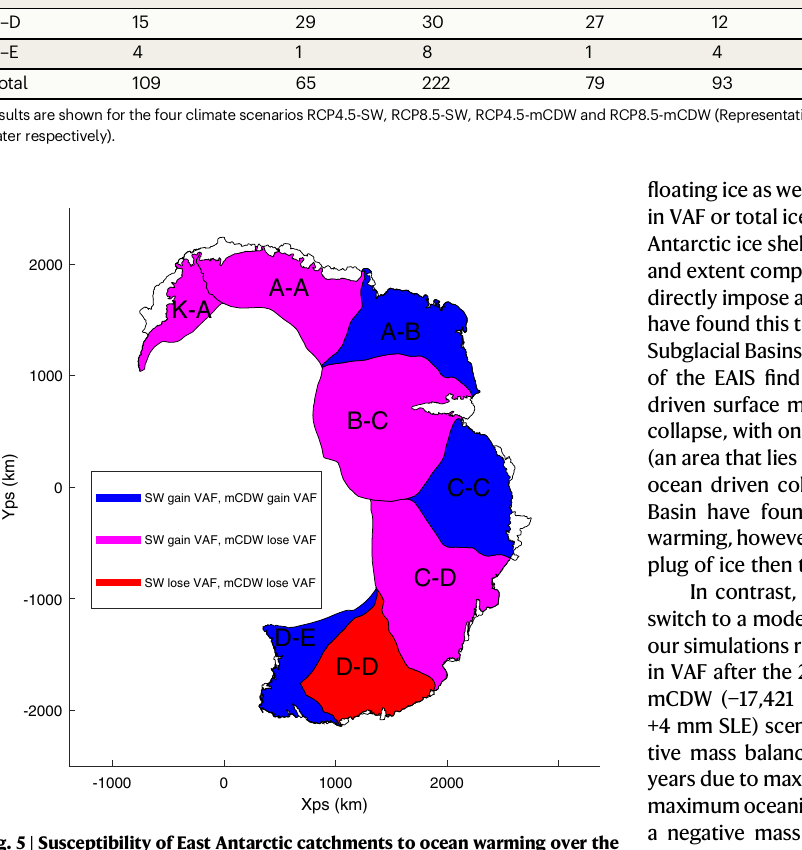
Fig. 5 | Susceptibility of East Antarctic catchments to ocean warming over the next 200 years. Blue regions show increased VAF (Volume Above Floatation) under all forcing scenarios, magenta regions show increased VAF for SW (Shelf Water) forced scenarios and decreased VAF for mCDW (modi fi ed Circumpolar Deep Water forced scenarios whilst red regions show reduced VAF for all scenario except the RCP8.5-SW (Representative Concentration Pathway). Regions corre- spond to the IMBIE 2016 catchments 49